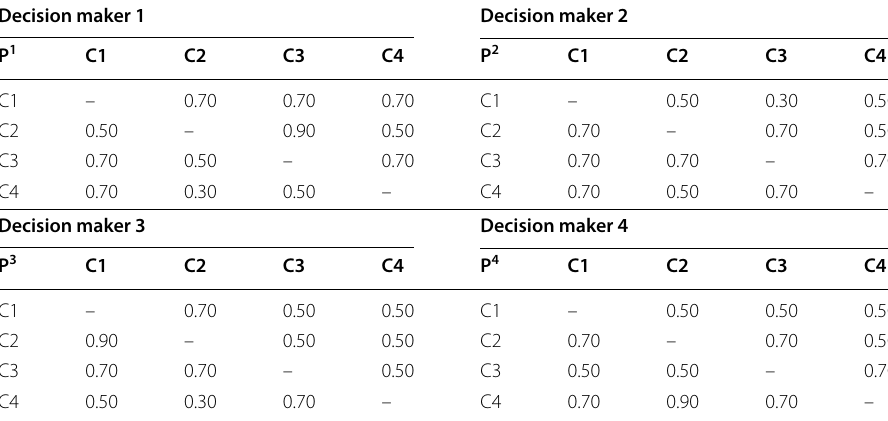
Table 13 Consensus-based fuzzy preference relations for peer-to-business debt model Decision maker 1